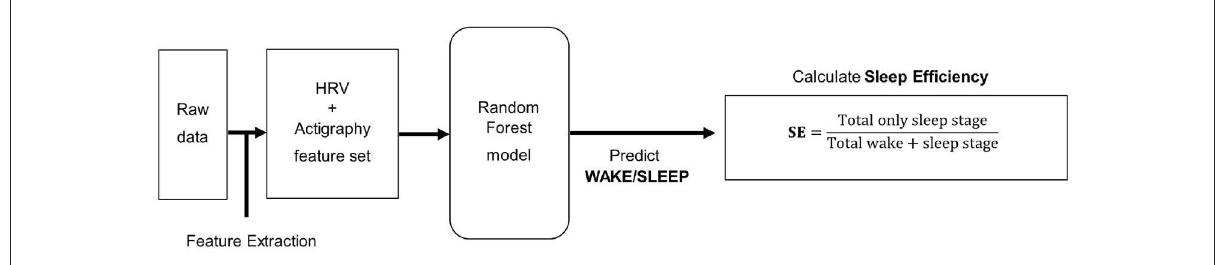
FIGURE2 This is a process flow diagram of sleep efficiency predicting